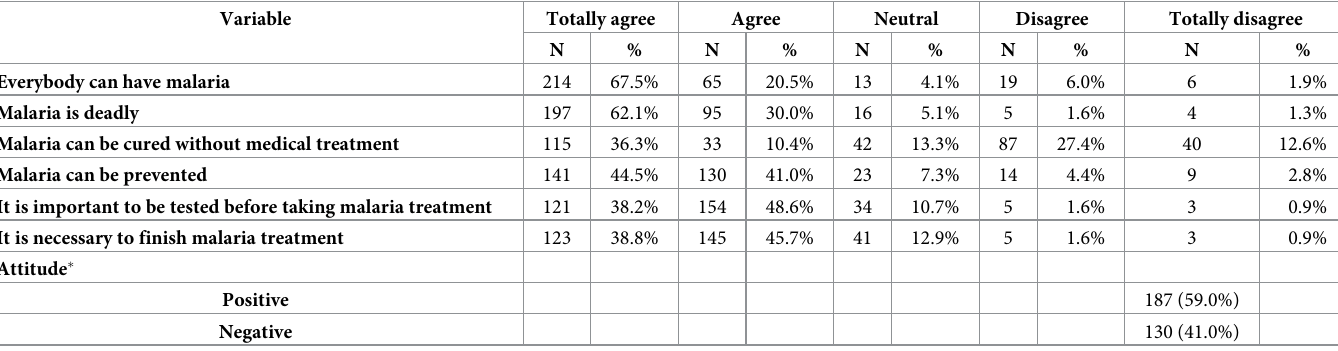
Table 3. Attitudes of the study participants towards